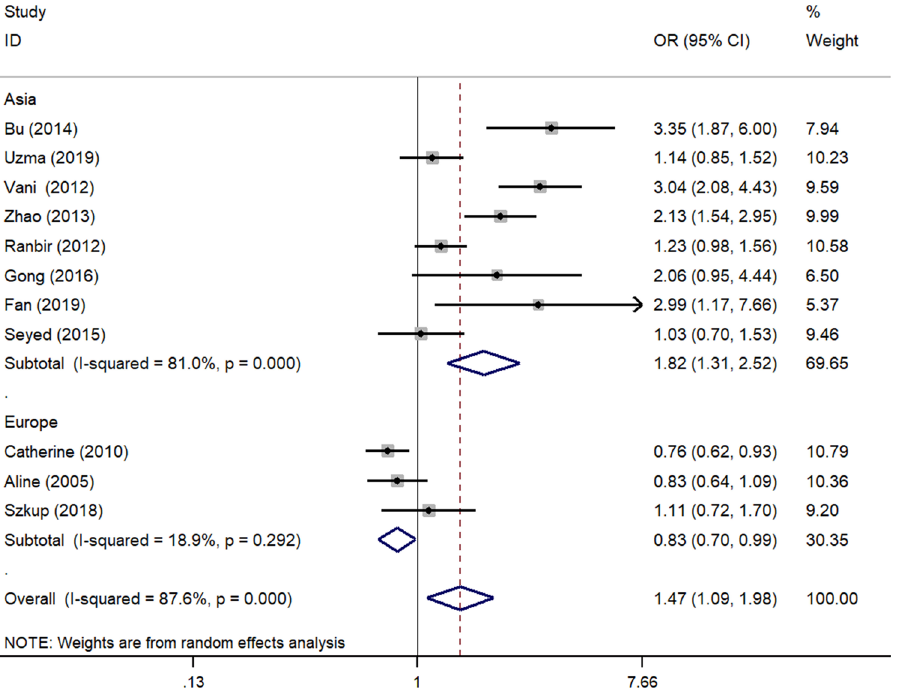
Figure 3. Subgroup analysis stratified by regions under allele model. OR odds ratio, CI confidence